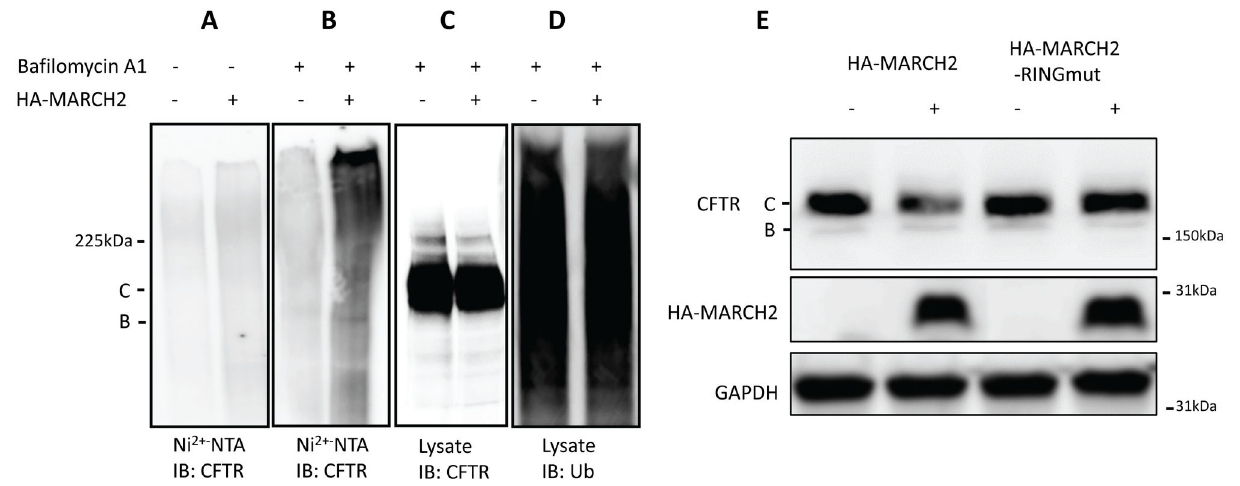
Figure 4. In vivo ubiquitination of CFTR by MARCH2. ( A ) HEK293 cells were first co-transfected with 3µg CFTR (pCMV-CFTR) and 3µg His -ubiquitin. After 24 h, the cells were transfected again with 1µg HA-MARCH2 or the vector plasmid pRK5KS. Twenty- 6 four hours after the second transfection, cell lysates were harvested under denaturing conditions (in a buffer containing 6 M guanidinium hydrochloride). Ubiquitinated proteins were affinity-purified with Ni 2+- NTA-agarose beads, eluted with Laemmli buffer, separated on SDS-PAGE, transferred to a PVDF membrane, and subjected to the immunoblot analysis with anti-CFTR mouse monoclonal antibody. ( B ) Same as in (A) except cells were treated with 400nM bafilomycin to inhibit lysosome activity 24 hours before harvest under denaturing conditions. Ubiquitinated proteins were affinity-purified with Ni 2+- NTA-agarose beads and subjected to the immunoblot analysis with anti-CFTR mouse monoclonal antibody. ( C ) Same as in (B) total cell lysates were subjected to immunoblot analysis with anti-CFTR antibody ( D ) The PVDF membrane in (C) was stripped and blotted with an anti-ubiquitinated proteins antibody FK2. Data shown are representative of at least three independent experiments. ( E ) HEK293 cells were co- transfected with 3µg CFTR (pCMV-CFTR) and 1µg HA-MARCH2 or HA-MARCH2 RING. Forty-eight hours after transfection, cell lysates were harvested and subjected to Western blot analysis with anti-CFTR mouse monoclonal antibody 217. Data shown are representative of at least three independent